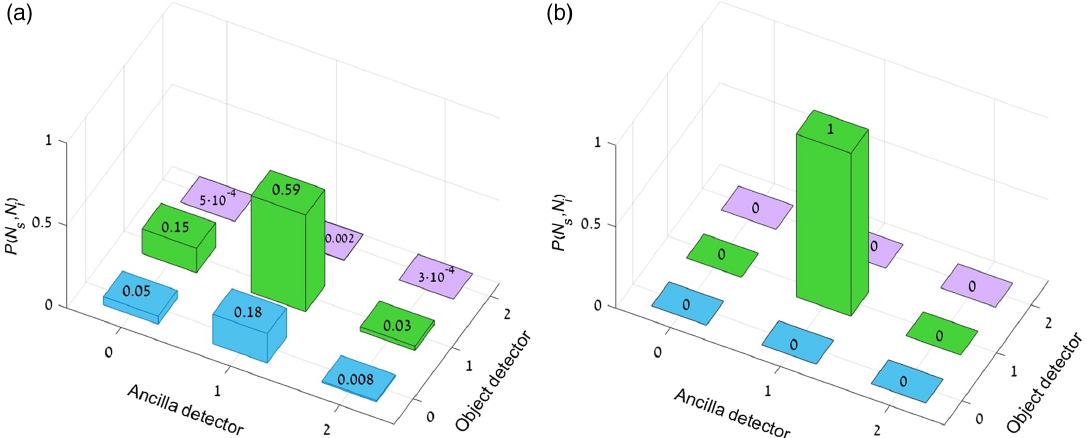
FIG. 2. Probability distribution of the number of photons that are detected by the ancilla (signal) and object (idler) detectors by using coincidence measurements with a time window of 1 μ s for (a) a classical source and (b) a PDC quantum source. The x axis represents the number of detected ancilla photons, and the y axis represents the number of detected signal photons, both in a time window of 1 μ